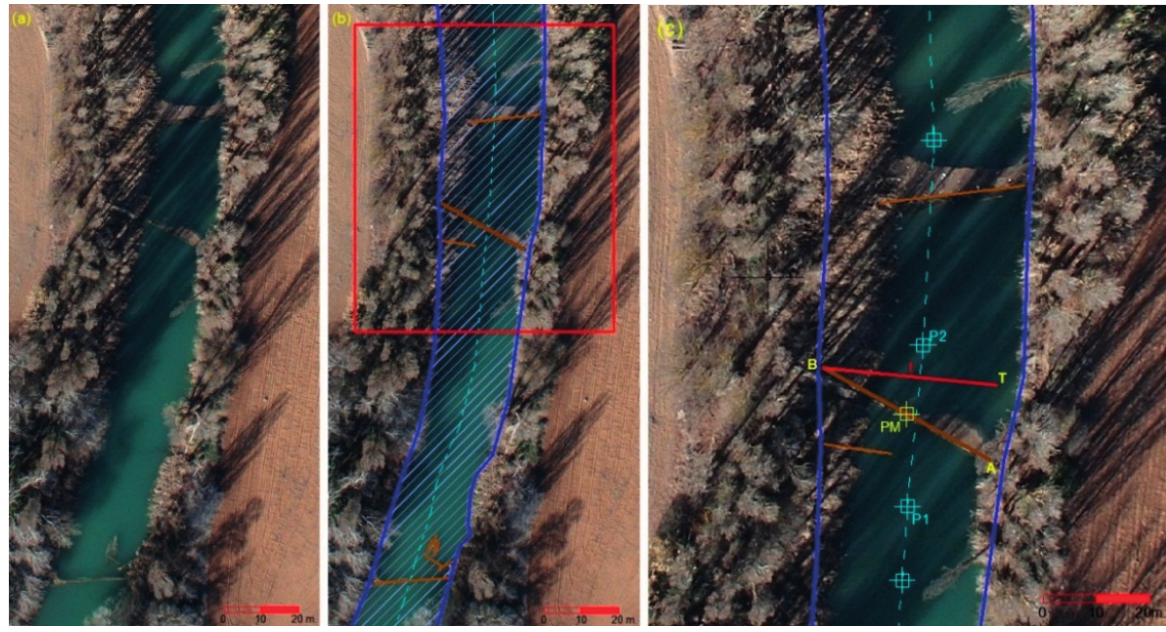
Figure 5. ( a ) Section of the channel with LWD; ( b ) geometric characterization of the LWD and river channel; ( c ) metric parameters related to the risk level of the